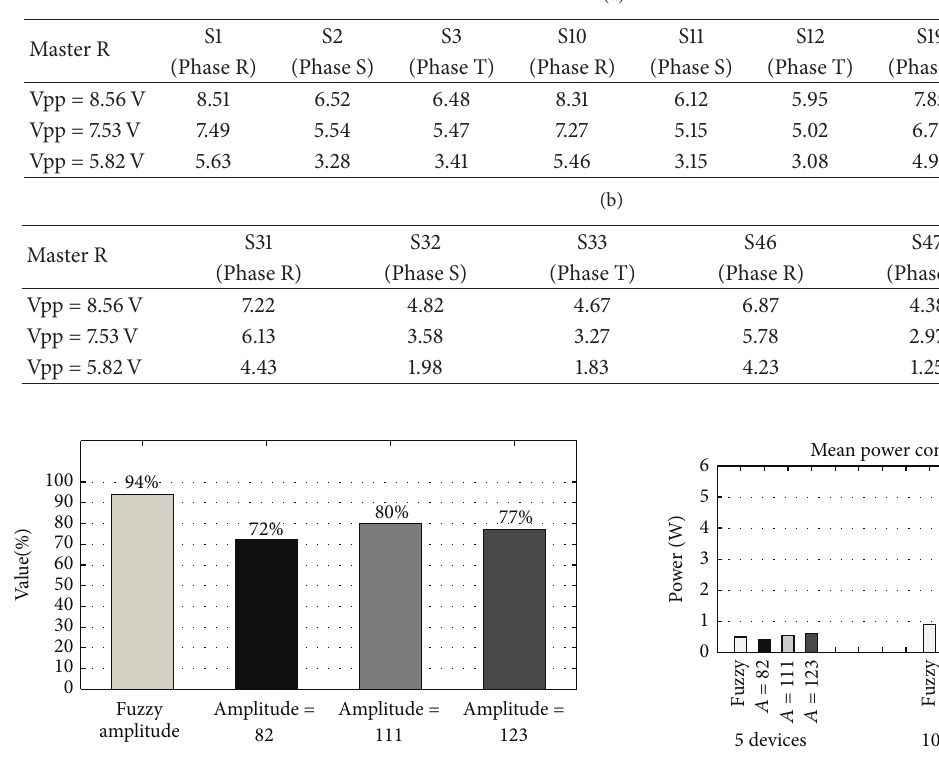
Figure 10: Power consumption comparison with 50 devices.